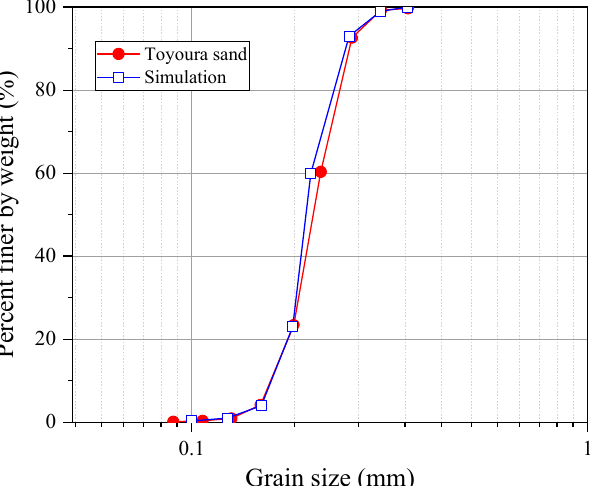
Figure 4. The particle size distribution of soil grains in the simulation and experimental test.